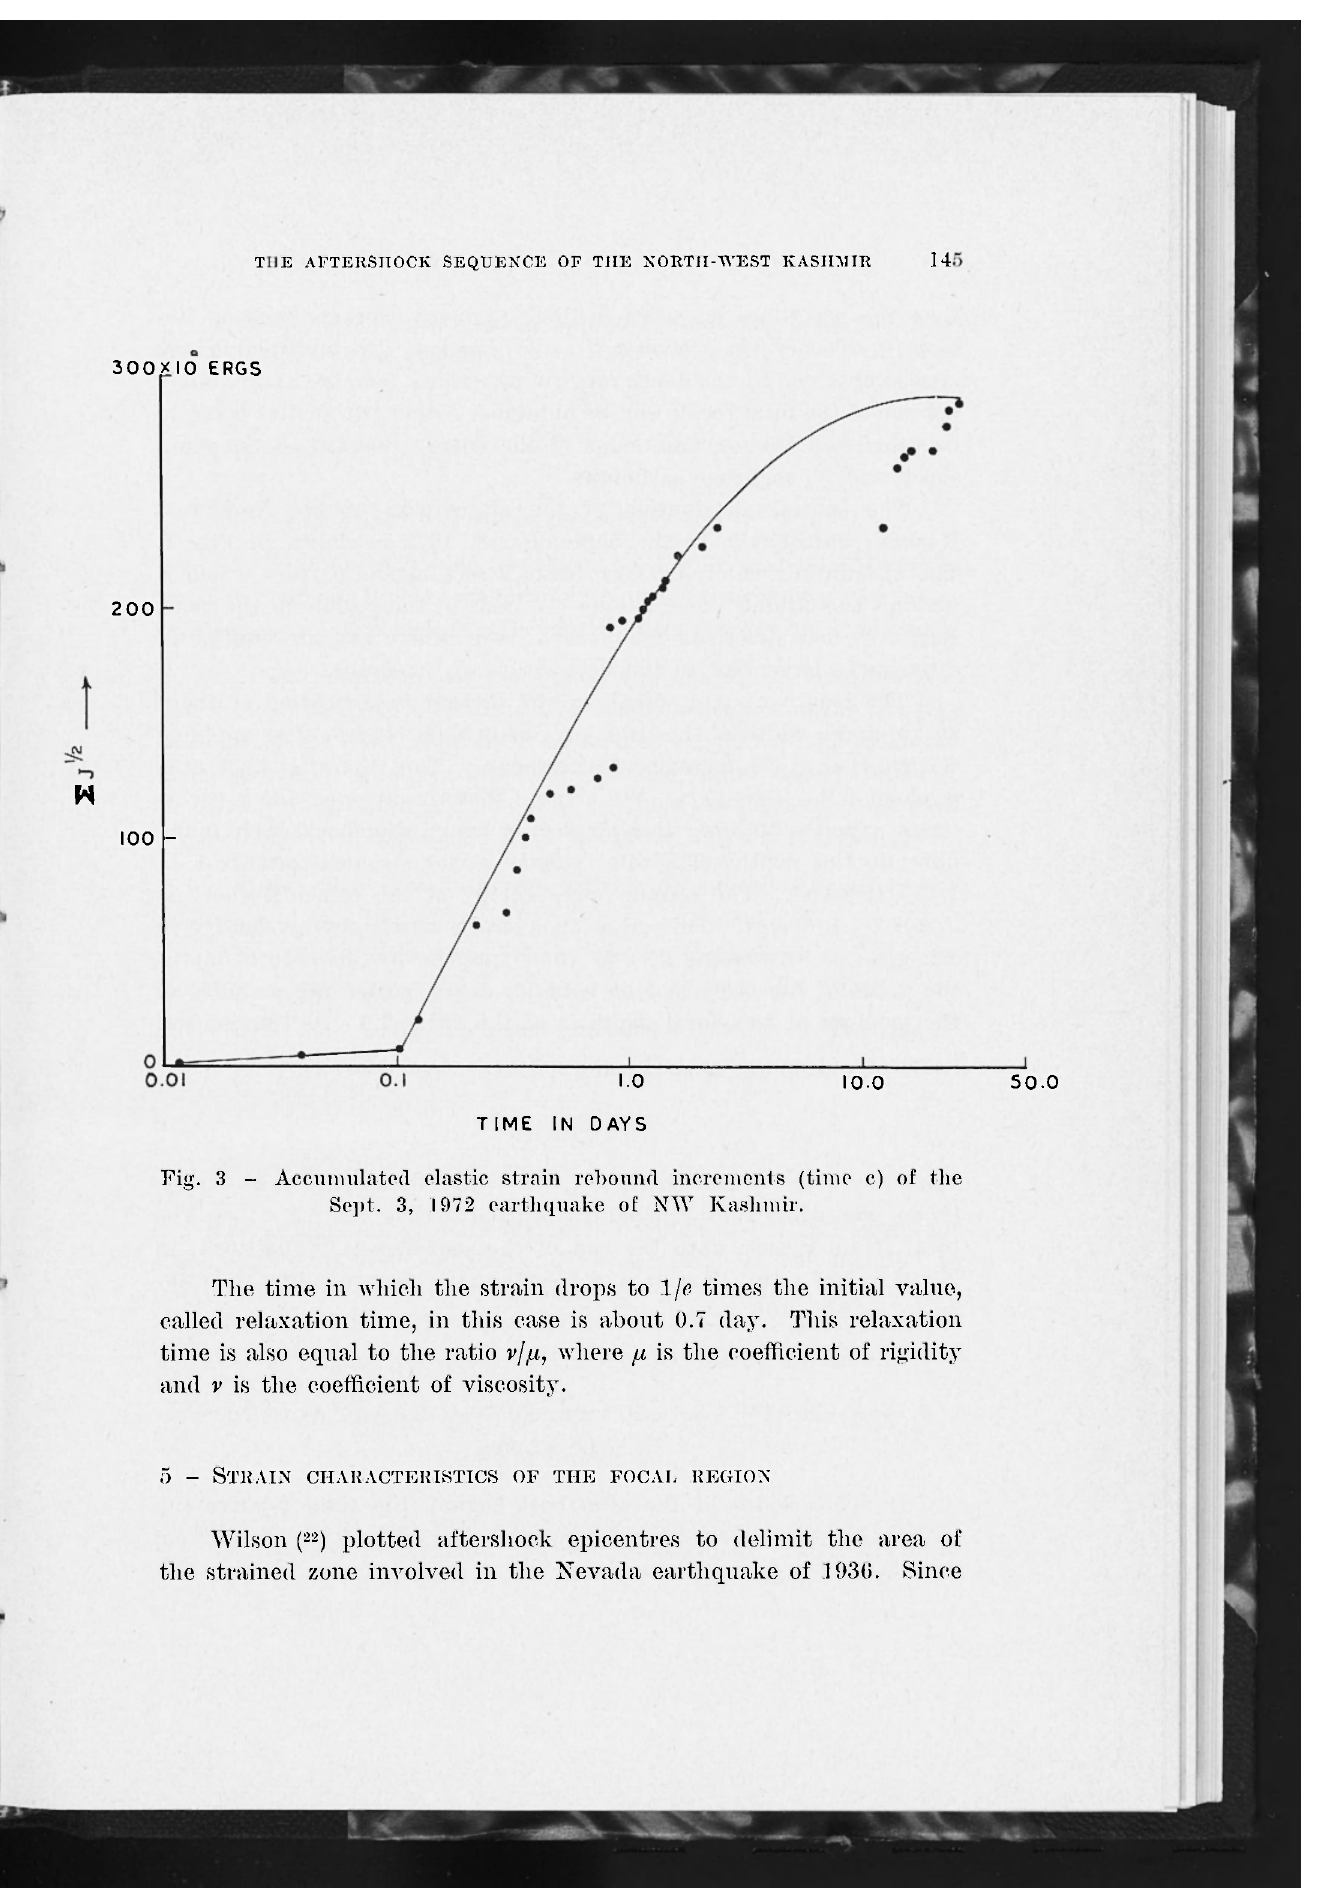
Fig. 3 - Accumulated elastic strain rebound increments (time c) of the Sept. 3, 1972 earthquake of NW